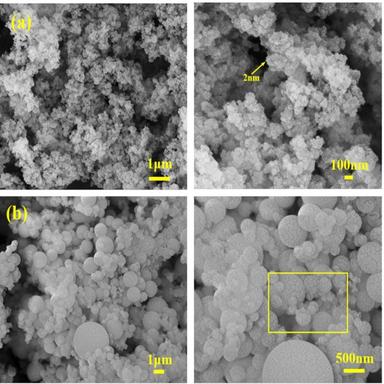
SEM images of (a) F–SiO2 and (b) F-FDB.